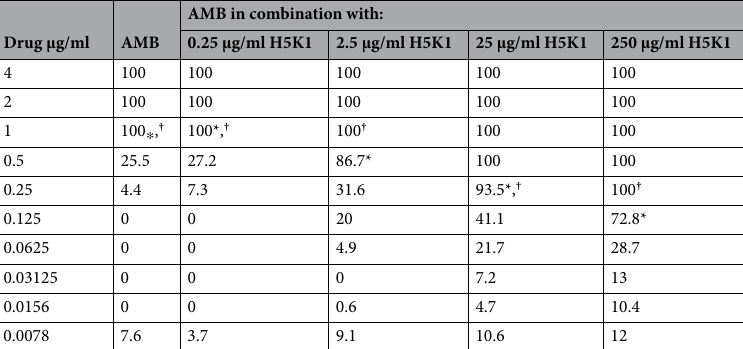
AMB in combination